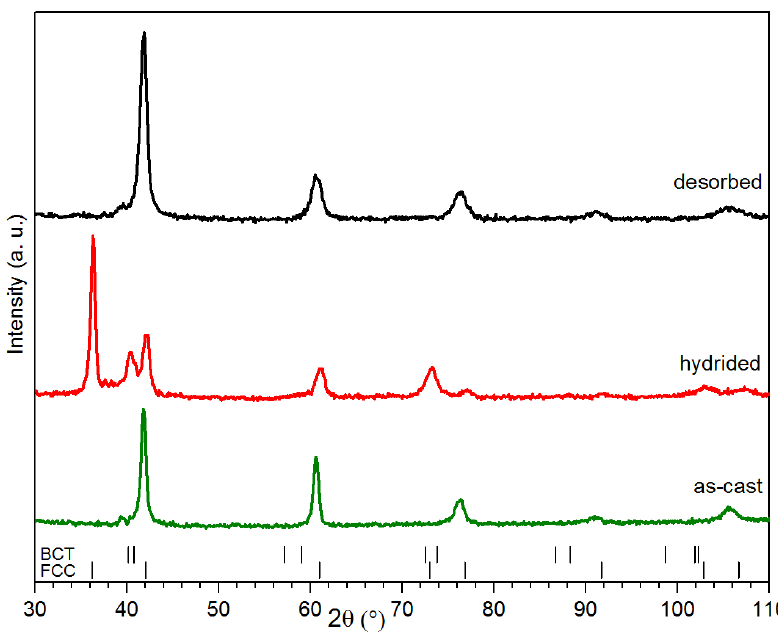
Figure 8. XRD patterns of Ti 1.26 V 0.315 (FeV) 0.315 Cr 1.11 + 4% Zr 7 Ni 10 alloy. Table 4. Crystal parameters of the co-melt Ti 1.26 V 0.315 (FeV) 0.315 Cr 1.11 + 4% Zr 7 Ni 10 . Uncertainties on last significant digit are indicated in parentheses.